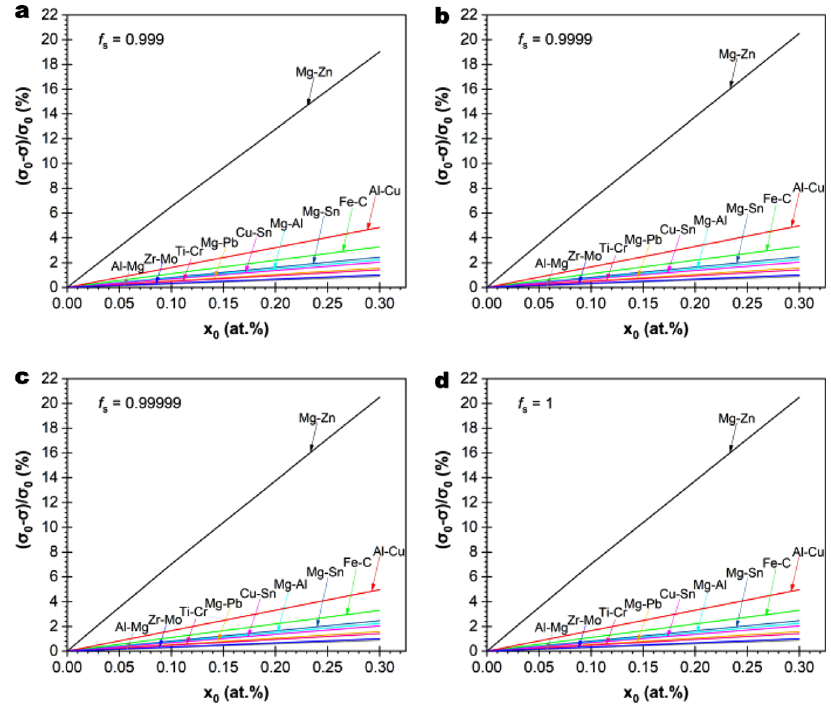
Fig. 7 | Effect of solute type and content on SGBM assessed through the inhi- liquid fi lm left). b f s =0.9999 (~10nm thick liquid fi lm left). c f s =0.99999 (~1nm (cid:3) (cid:4) = σ biting factor ( σ 0 − σ I )/ σ 0 . The values of σ 0 (cid:2) σ I thick liquid fi lm left). d f s =1 (complete solidi fi cation). Once f s reaches 0.99999, 0 are calculated using Eq. (11), with the solid fraction f s being varied from 0.999 to 1. a f s =0.999 (~100nm thick